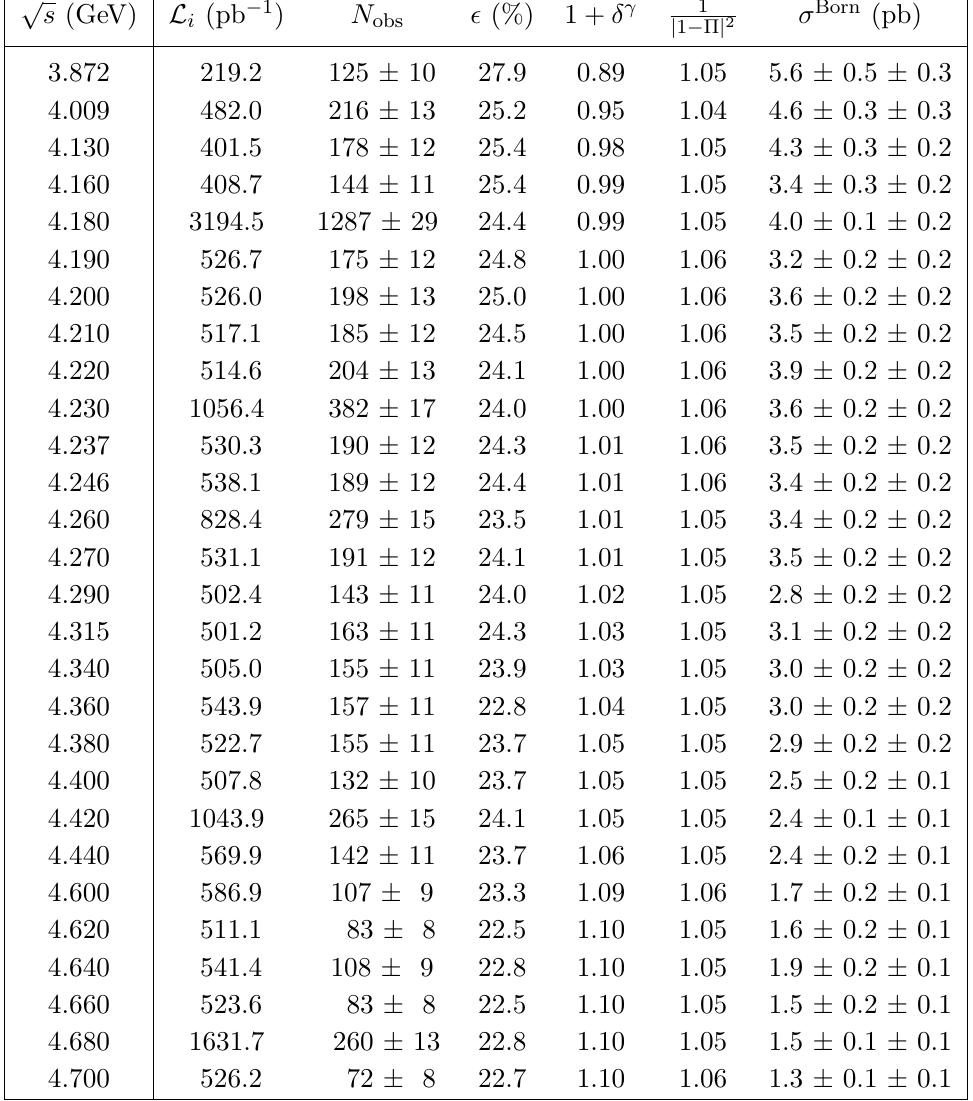
Table 3 . Numerical results for e + e − → ηρ 0 . The first uncertainties for cross sections in the last column are statistical uncertainties and the second ones are systematic, while those for N statistical